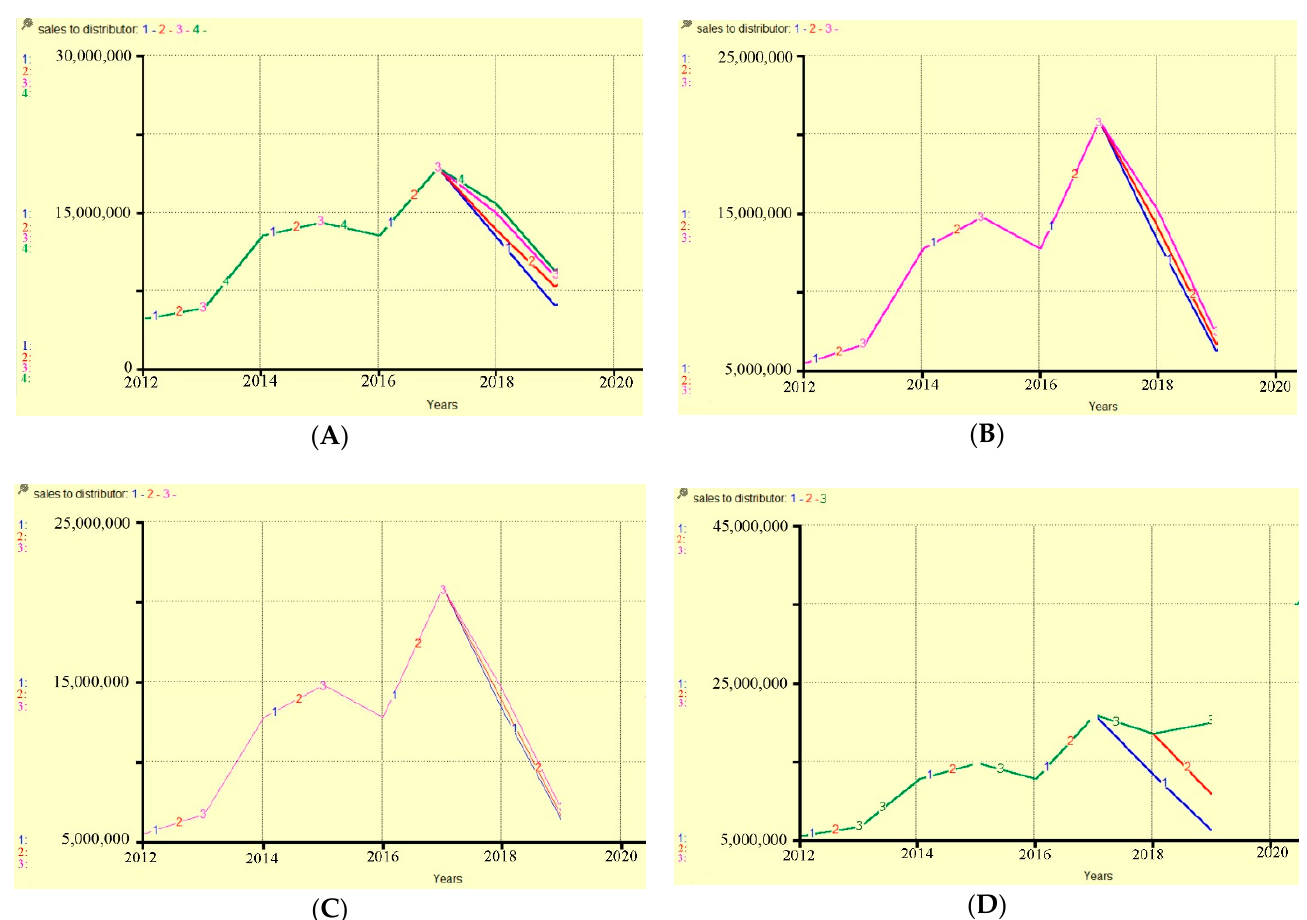
Figure 5. Numerical sales in different scenarios for the SD model between 2012–2019: ( A ) different advertisement amounts, ( B ) different R and D amounts, ( C ) different distributors number, ( D ) increase in advertisement, R and D, and number of distributors. Line 1 in all graphs presents the basic model.